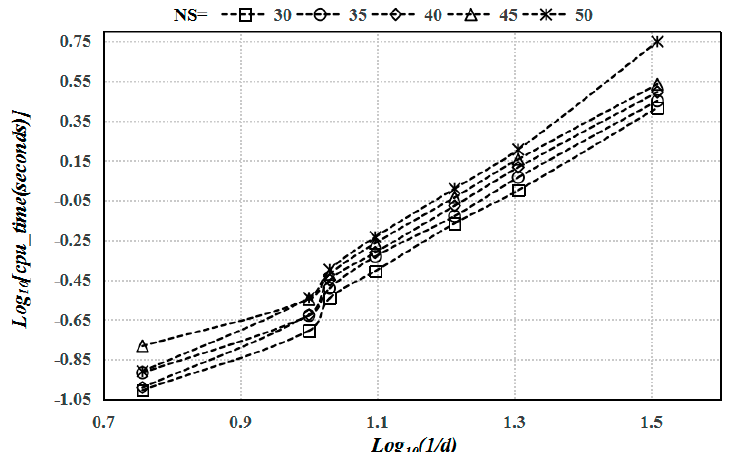
Figure 6. The computational time (CPU-time) for solving the bending deflection of an SSSS homogeneous plate subjected to a uniform load using the present method, with different values of nodes of star in a local domain.